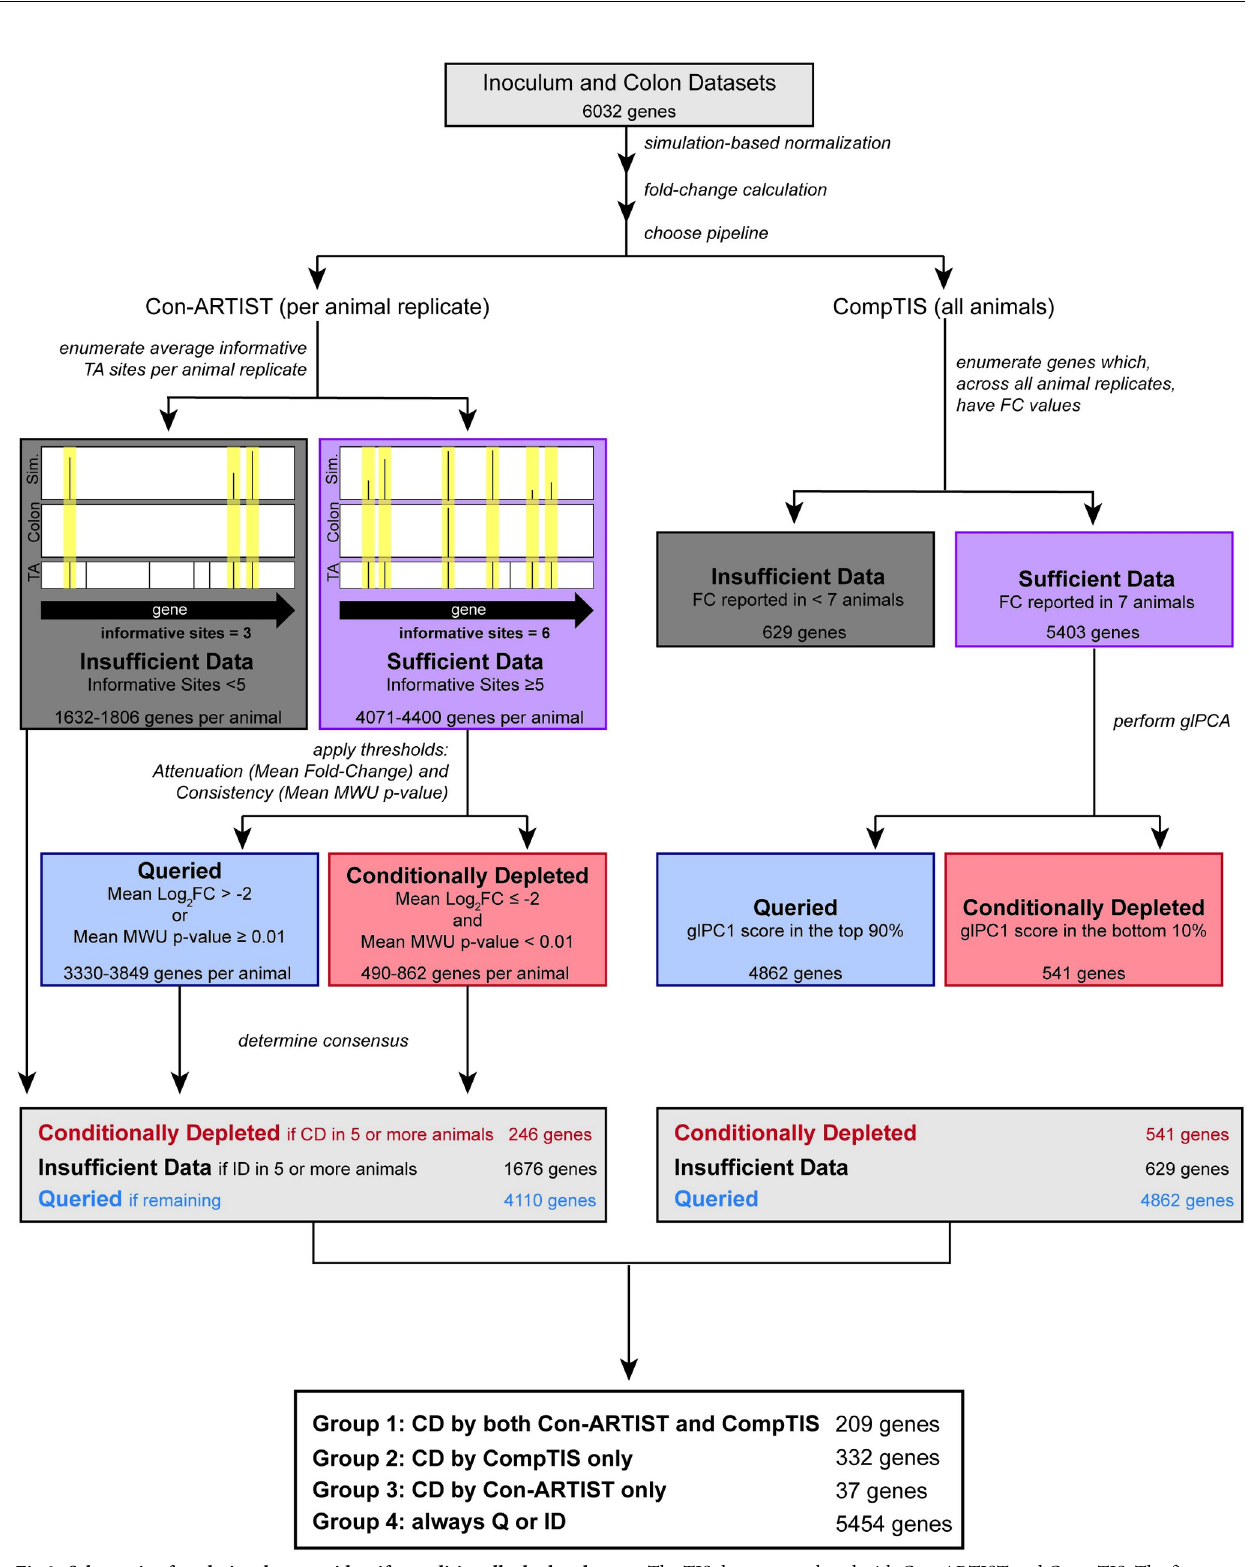
Fig 3. Schematic of analytic scheme to identify conditionally depleted genes. The TIS data was analyzed with Con-ARTIST and CompTIS. The first step in both pipelines is correction for bottleneck effects to facilitate identification of attenuated mutants. To do this, simulation-based normalization is performed on the inoculum dataset to model the stochastic loss observed in the colon datasets. Next, relative abundance of mutants (as represented by